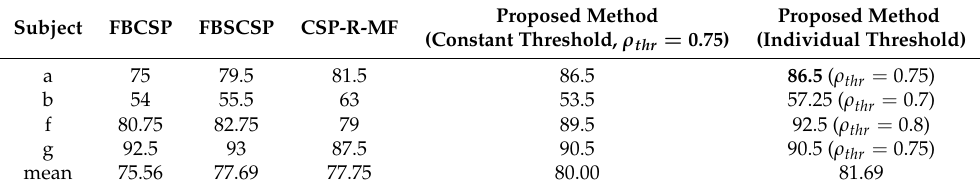
The 5 × 5 cross-validation classification accuracy of the proposed methods and frequency-optimized channel selection methods for BCI Competition IV Dataset